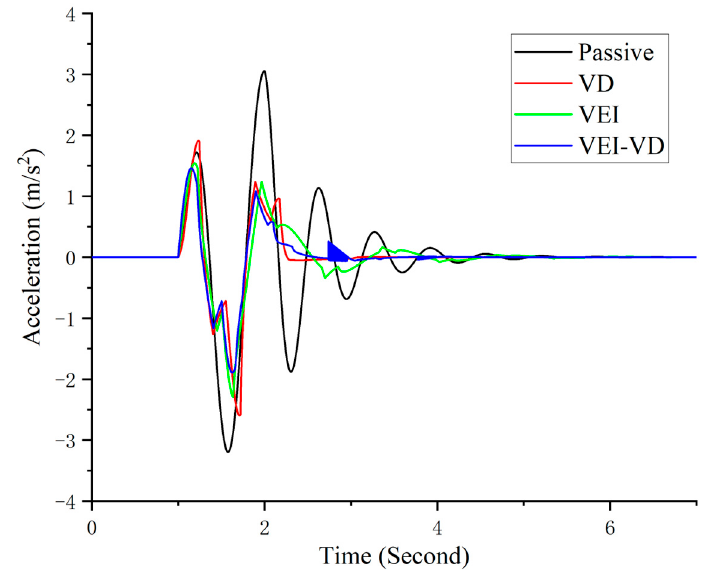
Figure 23. Acceleration under bump excitation.